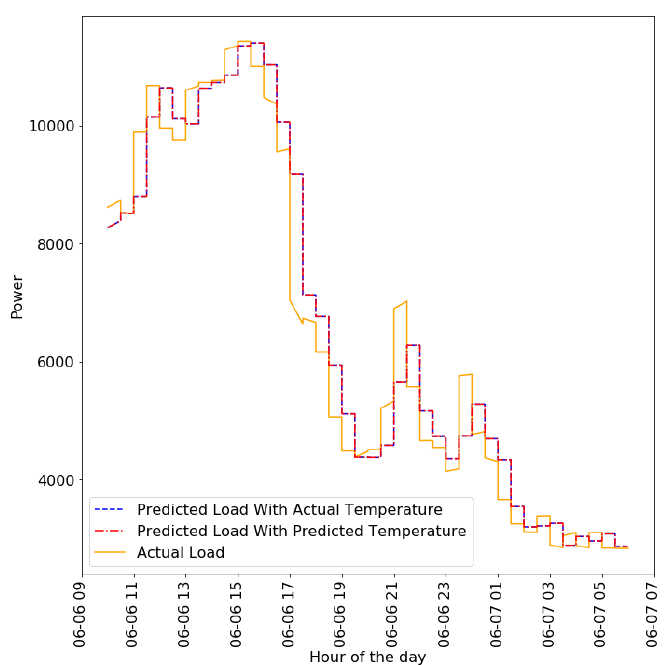
Figure 11. Actual Y2E2 lighting load (orange solid line), Short Term Forecast of the Y2E2 lighting load using Actual Temperature Input (blue dashed line) and Short Term Forecast of the same load using predicted Temperature Input (red dashed-dotted line) for a 20 h